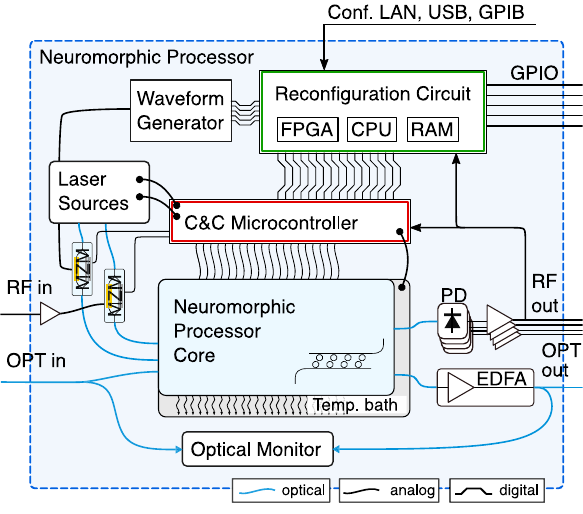
Figure 1: Simplified schematics of a neuromorphic